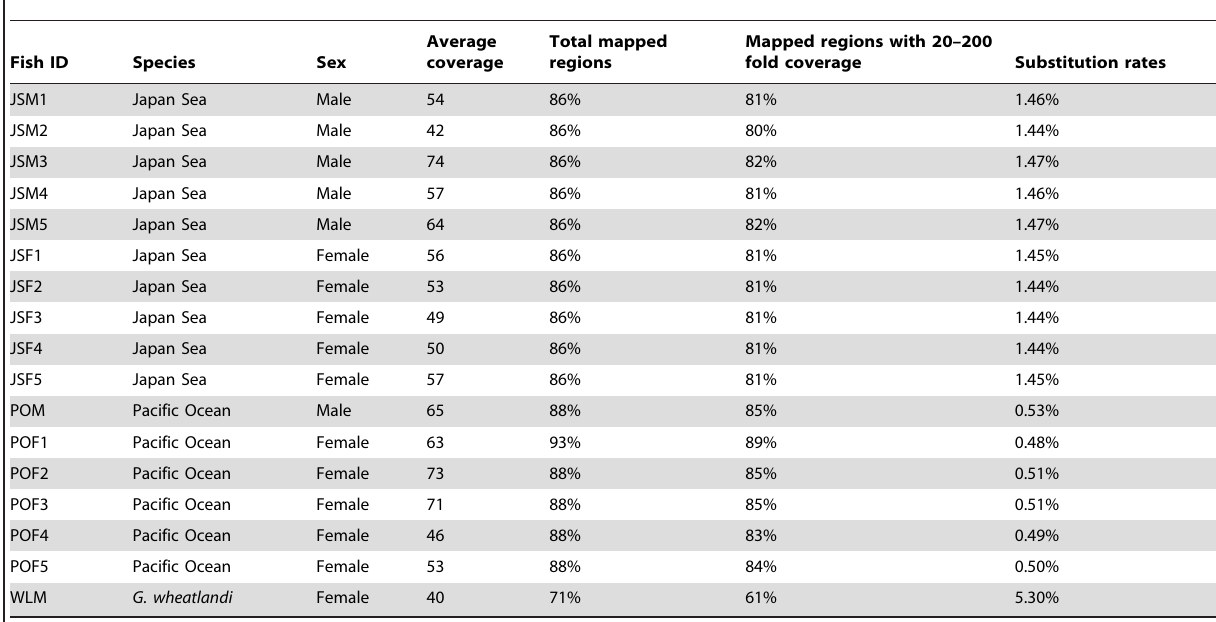
Table 1. Coverage and mapping rates of sequence reads and substitution rates compared to the reference genome sequence of an Alaskan lake